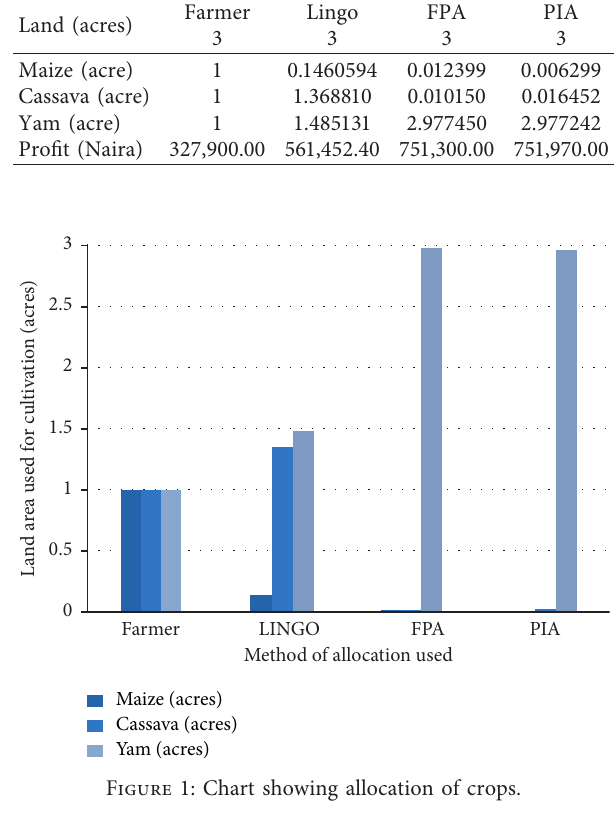
Figure 1: Chart showing allocation of crops.